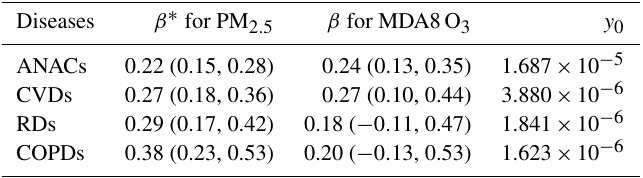
Table 3. Daily β and y 0 values for ANACs, CVDs, RDs and COPDs.